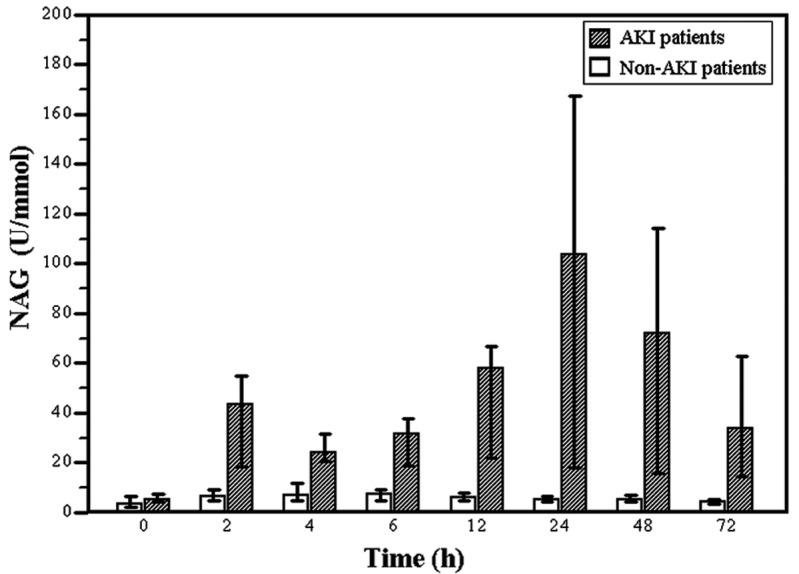
Comparison of N-acetyl-β-D-glucosaminidase (NAG) activities between acute kidney injury (AKI) and non-AKI patients. Levels in the AKI group increased at 2 h after surgery and were significantly higher compared to the non-AKI group (P<0.01).